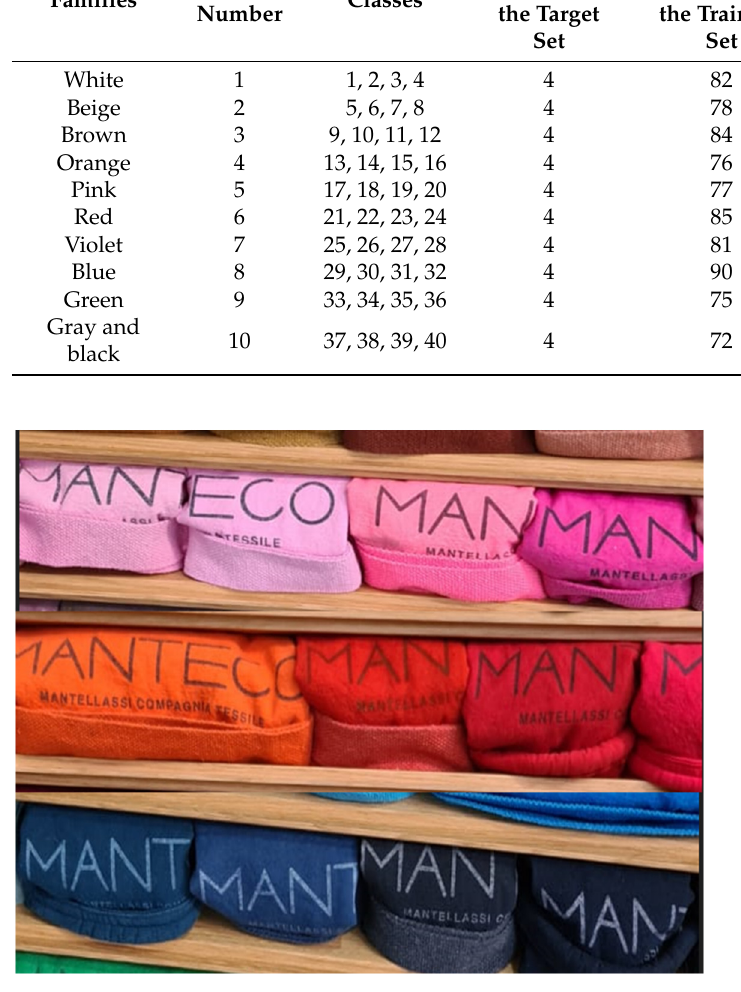
Figure 1. Four different classes for families “pink,” “red,” and “blue.”